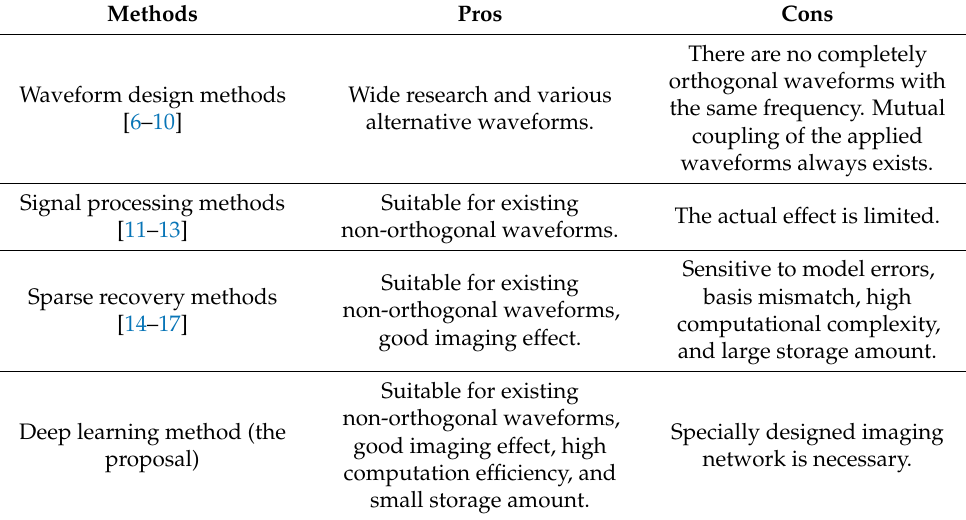
Table 1. Comparison of methods of suppressing the mutual coupling among different waveforms. Methods Pros